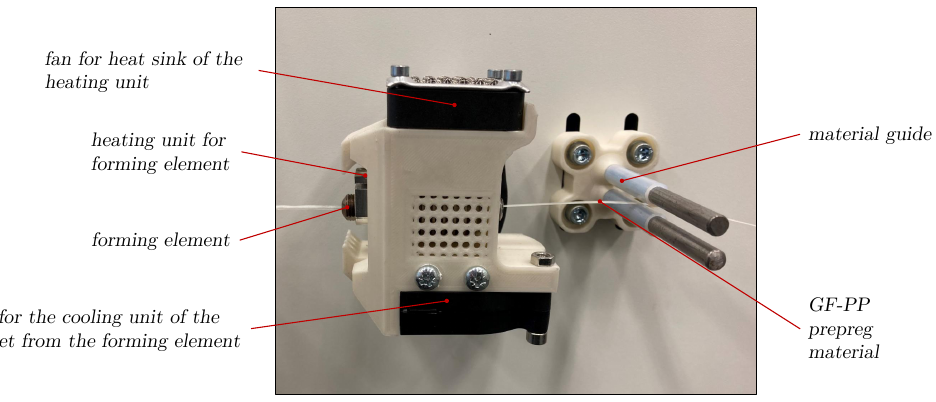
Figure 3. Forming unit to deform continuous fibre reinforced prepreg materials.